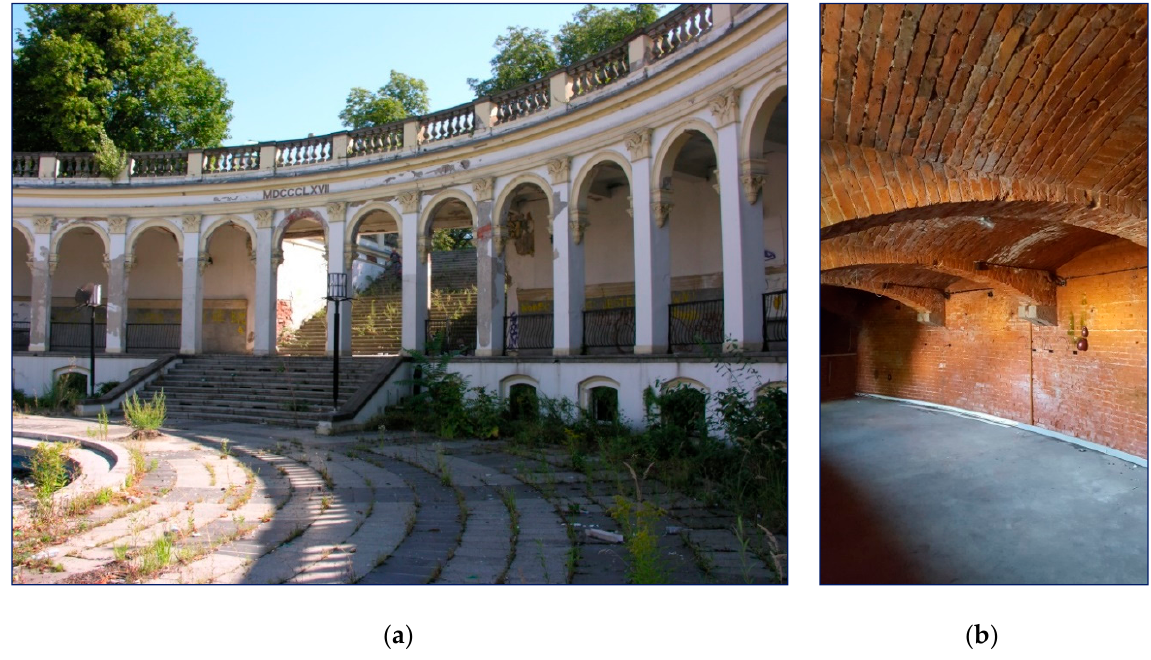
Figure 3. View of the colonnade building from the outside ( a ) and underground ( b ).